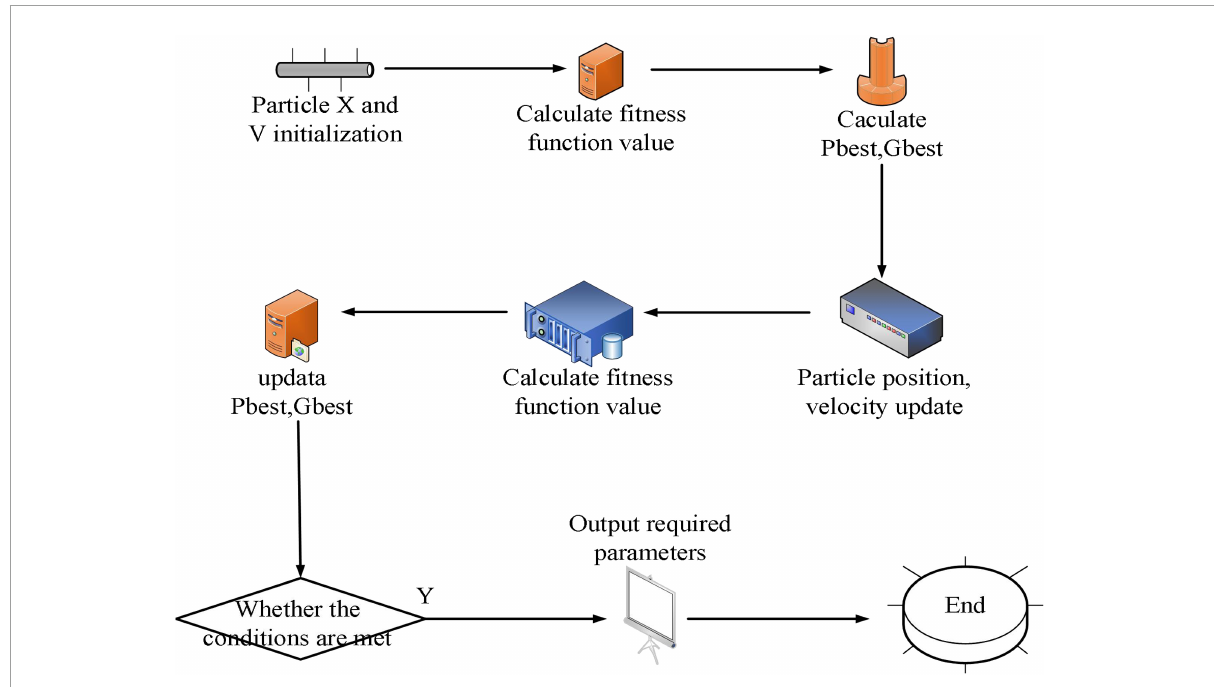
FIGURE1 Flow chart of particle swarm